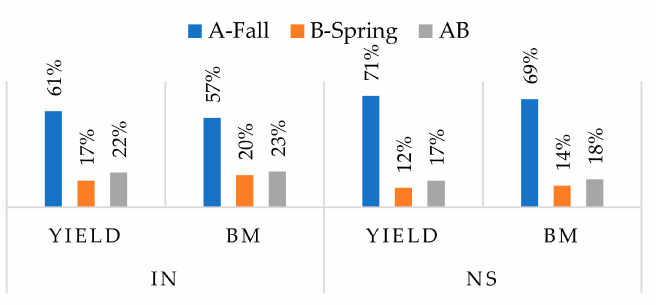
Figure 7. Contribution of partial variance of the factors on yield and biomass of the Ingenio and NS40S varieties in